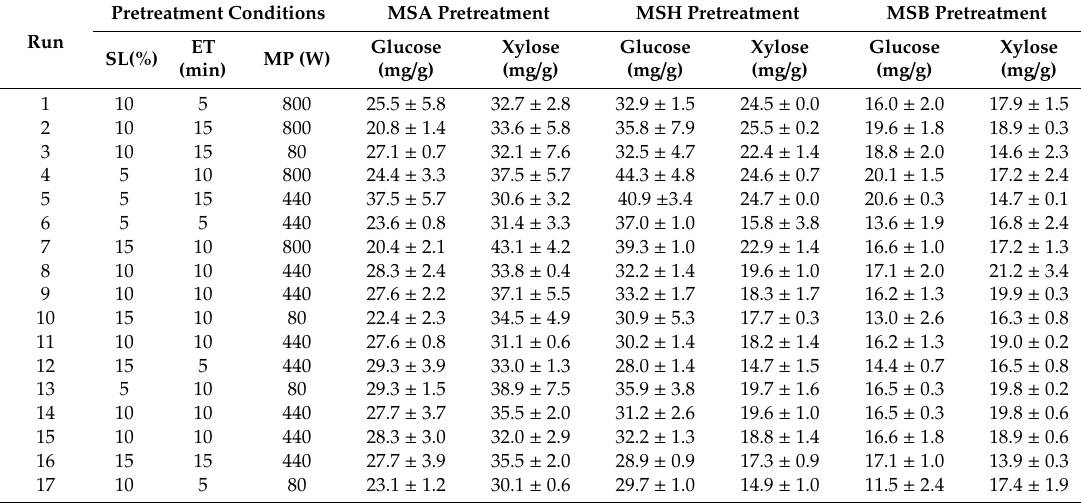
Table 3. Glucose and xylose yield after enzymatic hydrolysis of sago palm bark for MSA, MSH, and MSB